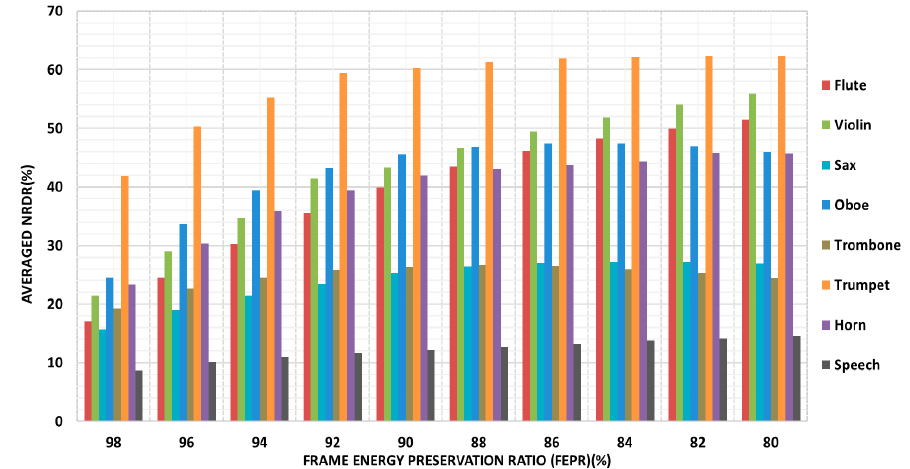
Figure A2. NRDR (Normalized Relative Difference Ratio) of eight types of audio signals under STFT (Short Time Fourier Transform) and MDCT (Modified Discrete Cosine Transform ) in various FEPR .